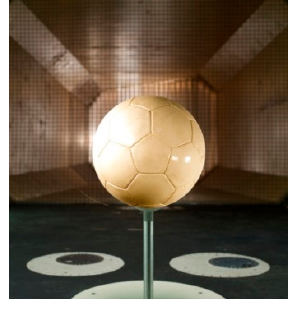
Figure 1. Wind tunnel